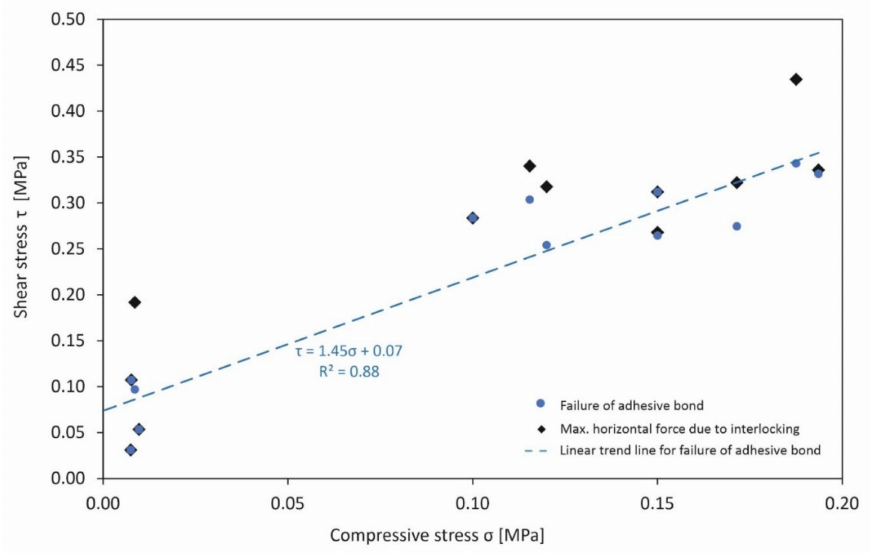
Figure 17. Determination of shear parameters and failure straight of a model stone